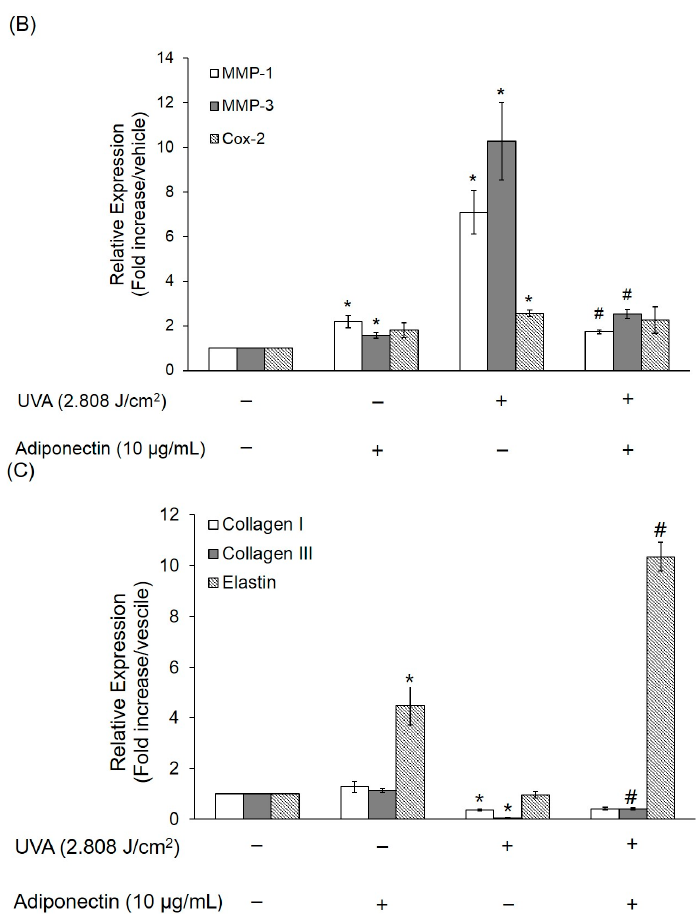
Figure 7. The effect of adiponectin on gene expression of UVA-irradiated Hs68 fibroblasts. ( A ) Gene expression of AdipoR1, AdipoR2, and EGFR on Hs68 fibroblasts, were measured by real-time PCR; ( B ) levels of MMP-1, MMP-3, and COX-2 mRNA expression of Hs68 fibroblasts; and ( C ) levels of elastin, type I and III collagen mRNA expression of Hs68 fibroblasts. The data were presented as the means ± standard deviation, n = 3–6. * p < 0.05 with respect to control; # p < 0.05 with respect to UVA.